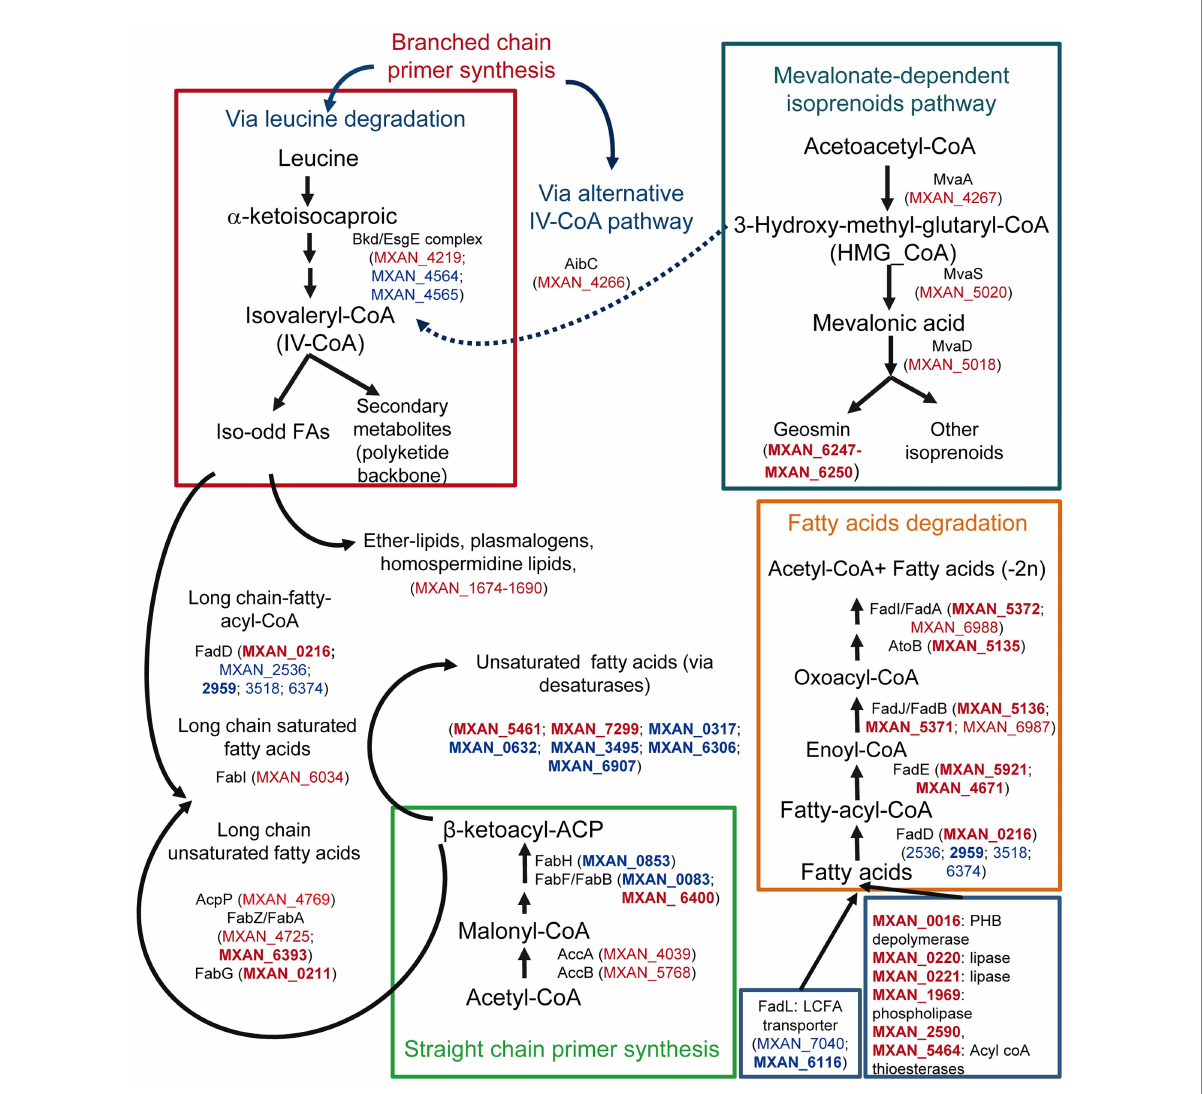
FIGURE 3 Differential expression during predation at t2 and t6 of genes involved in lipid biosynthesis and degradation, and their possible implication in lipid external use, and secondary metabolites biosynthesis. Red text indicates genes upregulated during predation. Blue text indicates downregulated genes. In bold, |Log2 Fold Change|>